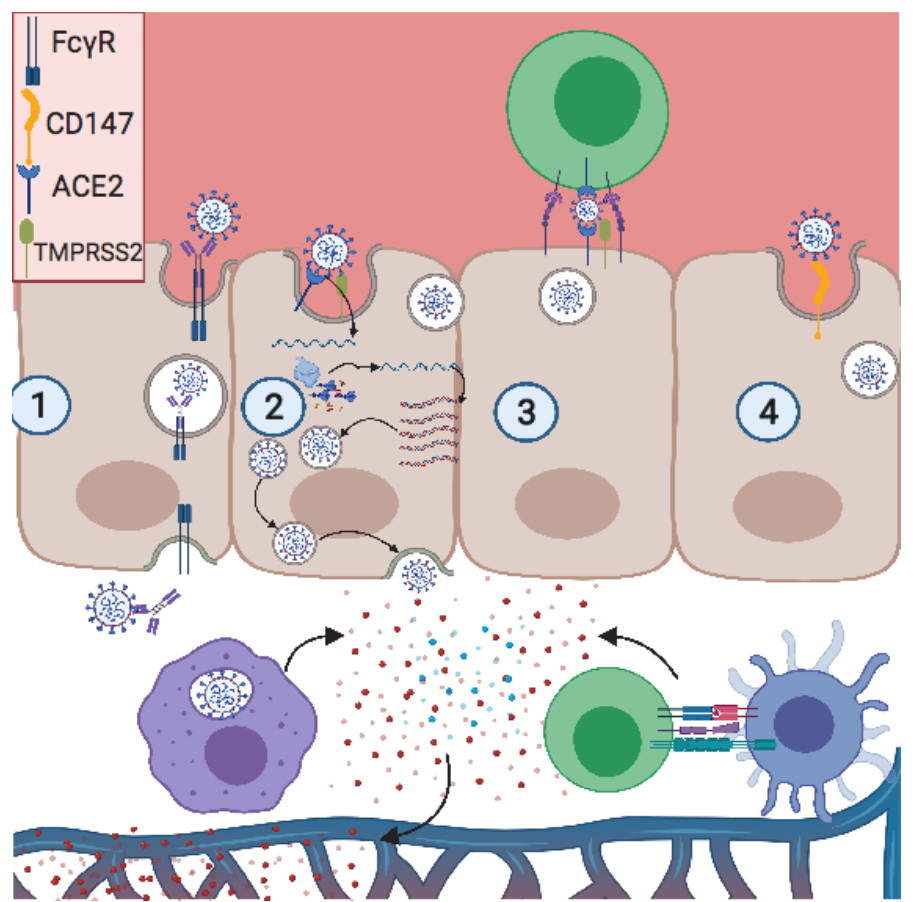
Figure 1. Potential modes of placental invasion by SARS-CoV-2. ( 1 ) Antibody-dependent en- hancement (ADE): the antibody neutralizing SARS-CoV-2 binds its Fc region onto FC γ R, expressed on the apical pole of the trophoblast. Then the neutralized virus is transcytosed into the basic pole, releasing the virus into the fetal extracellular matrix. ( 2 ) ACE2/TMPRSS2 pathway: the S2 subunit of the S protein interacts with ACE2 on the apical pole, promoting the fusion of the envelope with the membrane. This is followed by a proteolytic cleavage between S1 and S2 subunits by TMPRSS2, thus releasing the virus. The positive RNA translates the viral-RNA-dependent RNA polymerase and the viral proteins. Then this polymerase produces a high copy number of the viral genome, after which the virion is assembled and released on the basal pole. ( 3 ) Cell-to- cell contact: LFA1 expressed on infected T cells interacts with ICAM1 expressed on the trophoblast apical pole, forming a tight interaction and close proximity between two membranes. Thus, the viral release in the placental immune synapse can facilitate viral infection. ( 4 ) CD147 expressed on the apical pole of the trophoblast interacts with viral particles, promoting viral infection. Created with BioRender.com.